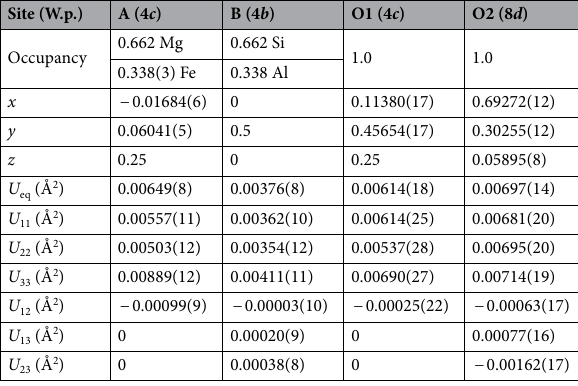
Table 4. Refined structural parameters. W.p. Wyckoff